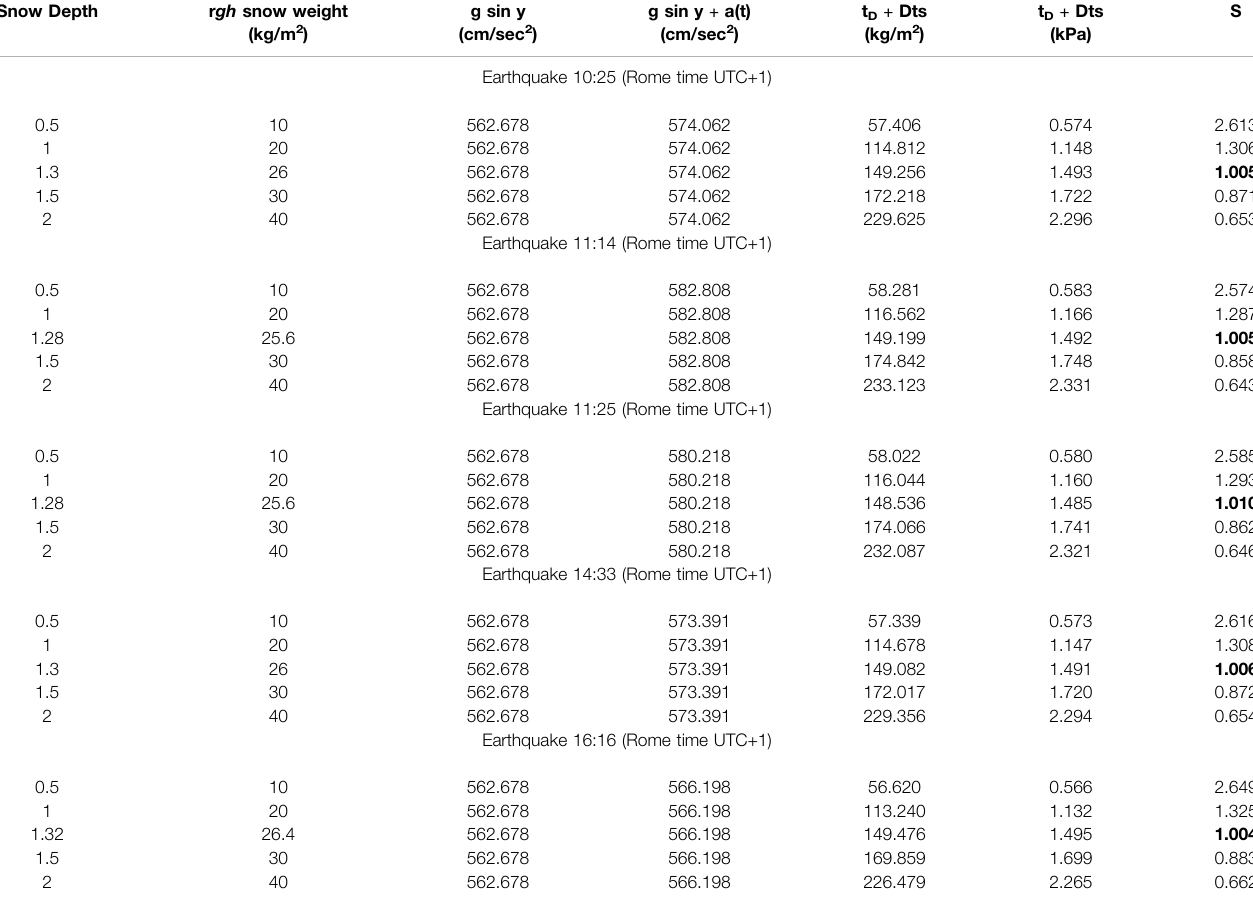
Bold entries outline expected triggering of the avalanche (see Supplementary Appendix B for details and de fi nition of the lettering)